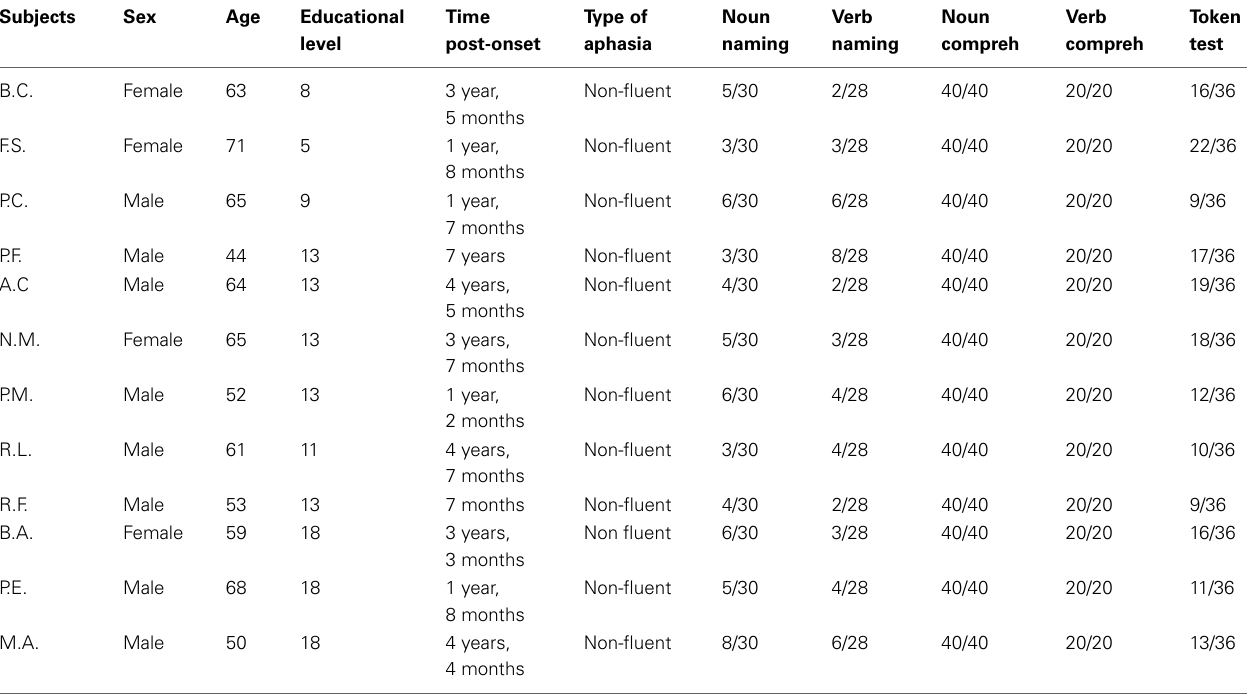
Table 1 | Sociodemographic and Clinical data of the 12 non-fluent aphasic